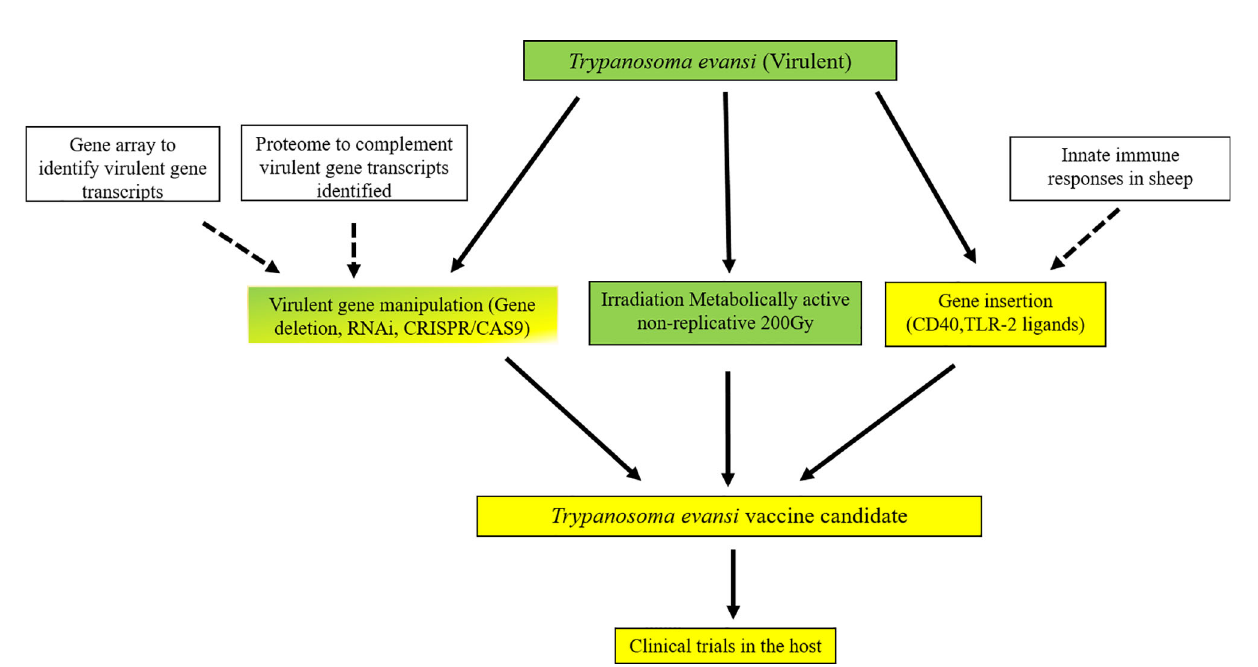
FIGURE 10 | Potential pathway to an effective vaccine for T. evansi in livestock. An outline for developing a genetically manipulated and irradiated but metabolically active vaccine against Trypanosomosis in livestock species. Green signi fi es areas well studied, green/yellow areas are those that have been attempted, yellow are yet to be studied. White boxes are areas that are continuously under study that produce new information for vaccine development. All genes identi fi ed across doses were analysed in a matrix that considers the changes in the level of transcription at 100Gy compared to both 140Gy and 200Gy irradiation of T. evansi and functional analysis using gene ontology enrichment to identify pathways that are affected by low dose irradiation. Further analysis to look at immune functions of genes identi fi ed using gene deletion methods e.g., gene knock-out, RNAi or CRISPR/CAS9. Gene insertion of immune modulation ligands would further enhance immunogenicity of the whole parasite inoculum before testing in the mammalian